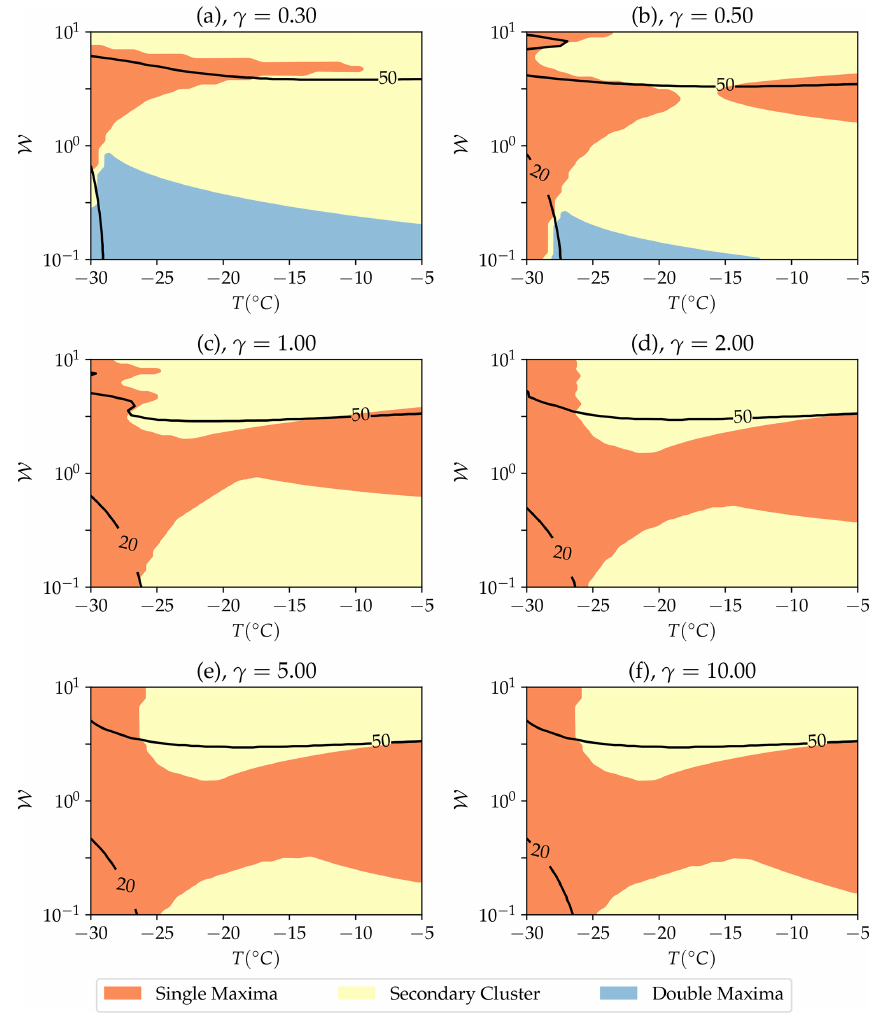
Figure 10. Regime diagram of the different fabric patterns which occur (defined in Fig. 1). The angle of the primary cluster in Fig. 11 at 20 and 50 ◦ is also overlaid. The diagrams are shown for discrete strain values. The resolution of this figure is 50 × 50 across the parameter